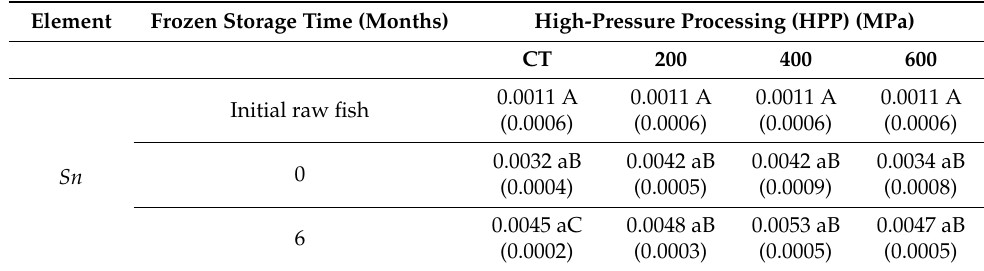
Table 4. Determination (mg · kg − 1 dry muscle) of two metals ( Sn and Pb ) and two metalloid ( As and Se